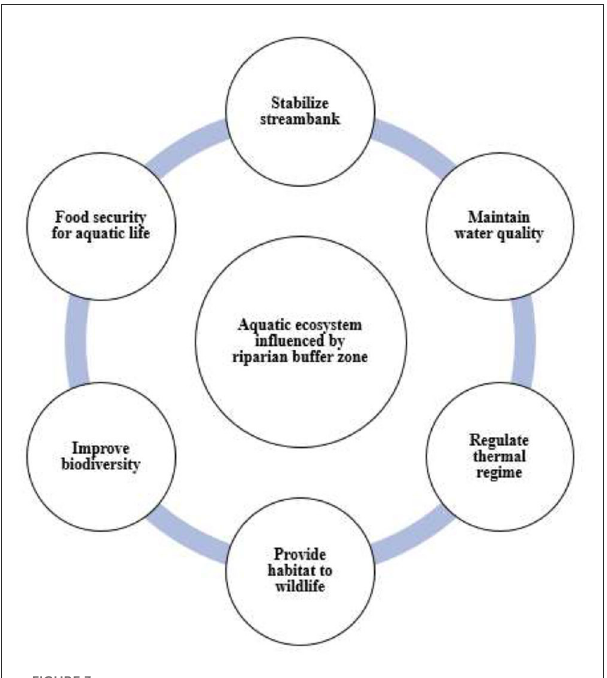
FIGURE3 Influence of riparian buffer zone on aquatic